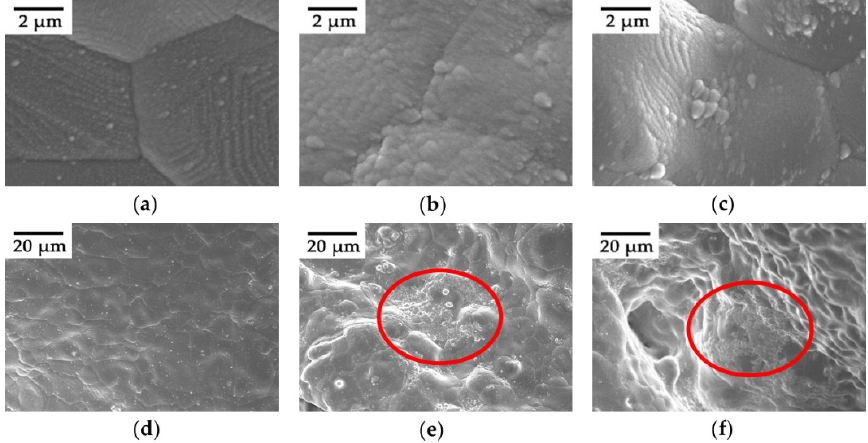
Figure 4. SEM micrographs of different areas on the surface of sample #9. ( a − c ) film surface morphologies with a scale of 2 μ m and ( d − f ) with a scale of 20 μ m.